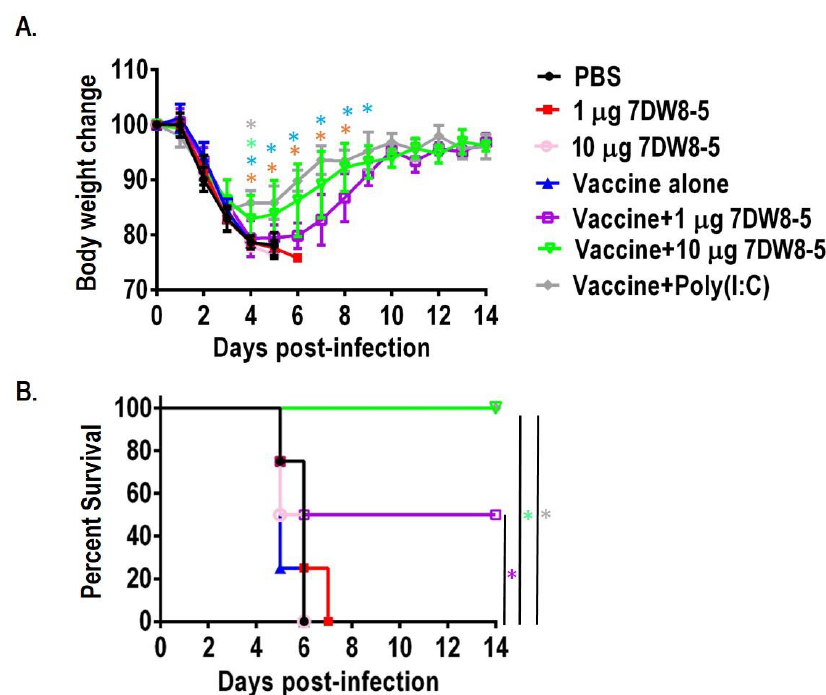
Figure 2. Body weight change and survival rate of the immunized mice with the split inactivated influenza vaccine plus 7DW8-5 by intranasal administration after a lethal challenge by MA-CA04 virus. Six-week-old BALB/c mice were intranasally immunized with the indicated immunogens (20 μL total, 10 μL/ nostril) twice with a two-week interval between immunizations. Four mice were used per group. Three weeks after the second immunization, the mice were challenged with 10 MLD 50 of MA-CA04 virus. Body weight and survival were monitored daily for 14 days. ( A ) Body weight change in the immunized mice after lethal infection; ( B ) Survival of the immunized mice after lethal challenge. Green asterisks indicate a significant difference between the vaccine + 10 µ g 7DW8-5 group and the vaccine alone; gray asterisks indicate a significant difference between the vaccine + Poly(I:C) group and vaccine-alone group; purple asterisks indicate a significant difference between the vaccine + 1 µ g 7DW8-5 group and vaccine-alone group; orange asterisks indicate a significant difference between the vaccine plus 10 µ g of 7DW8-5 group and vaccine + 1 µ g 7DW8-5 group; blue asterisks indicate a significant difference between the vaccine + Poly(I:C) group and the vaccine + 1 µ g 7DW8-5 group. * p <